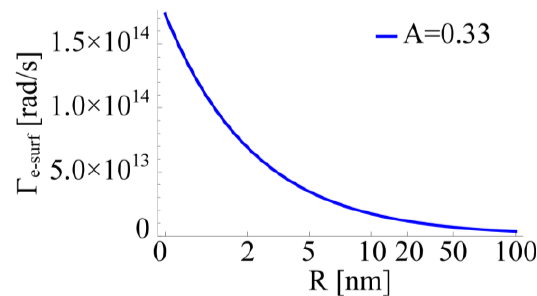
Figure 10. Electron-surface scattering for a gold sphere with different radii. A shape factor A = 0.33 has been